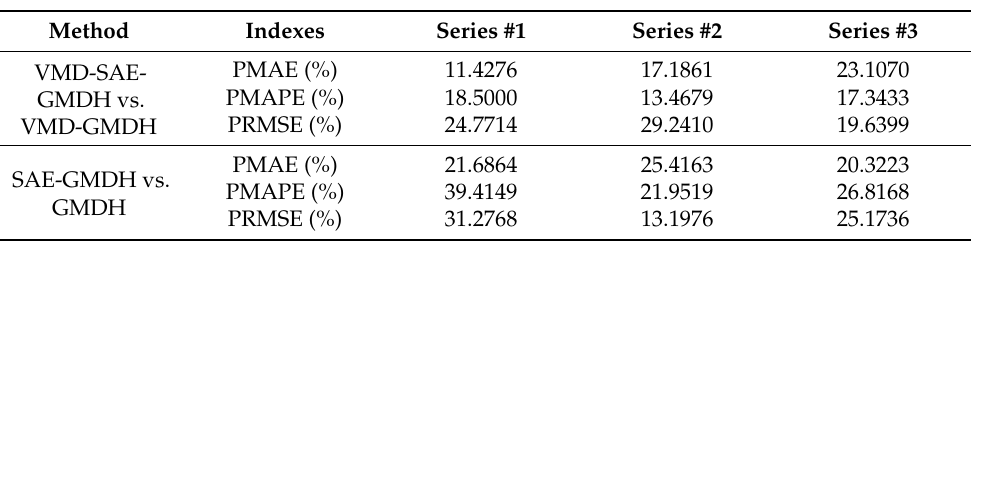
Table 3. The promoting percentages of the SAE